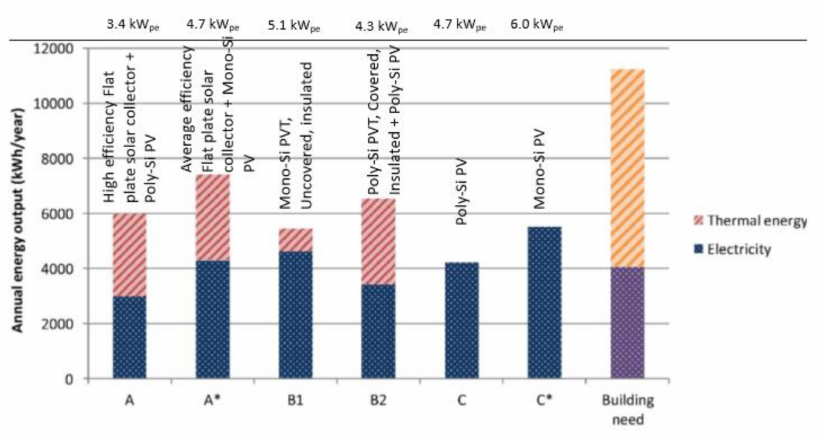
Figure 24. Annual thermal and electricity generation of different variants (reprinted from [118], with permission from publisher and information is